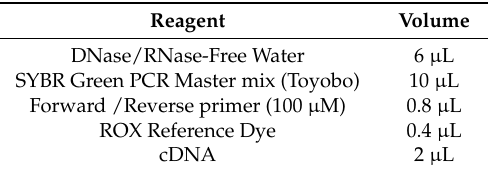
Table 1. RT-PCR mixture.